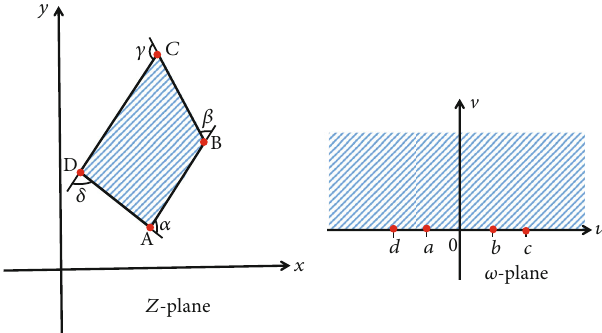
Figure 9: The Schwarz-Christo ff el map that maps the area inside the polygon to a rectangle.